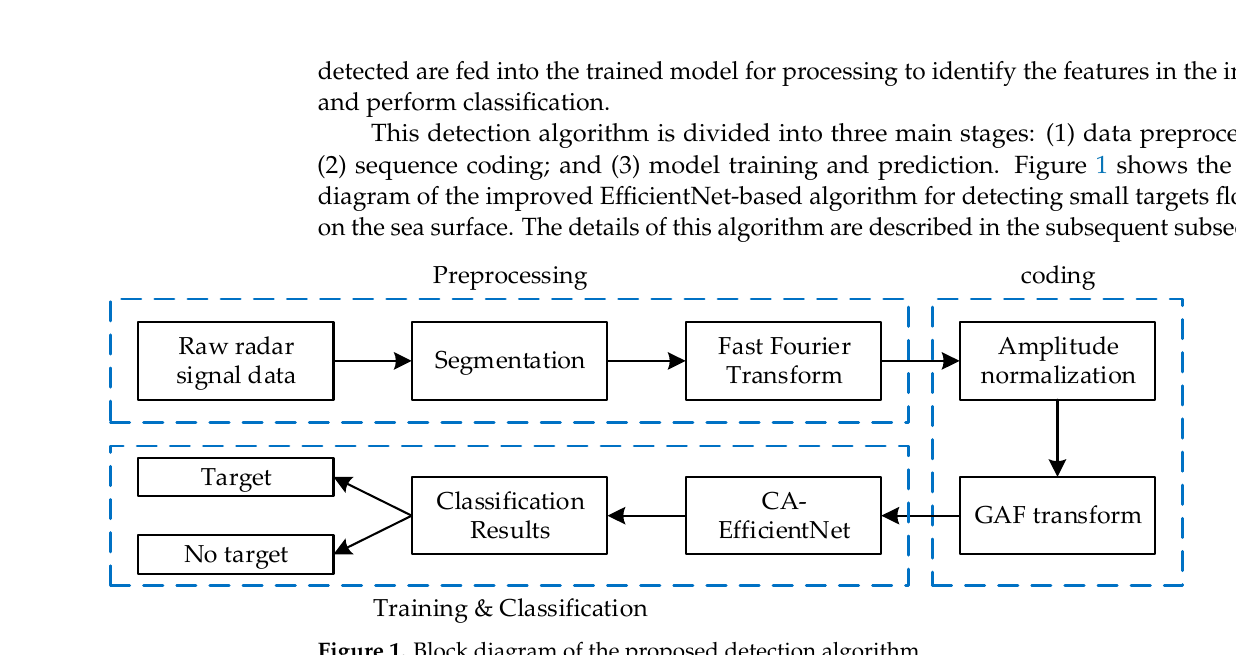
Table 1. 1993 IPIX radar data main parameter